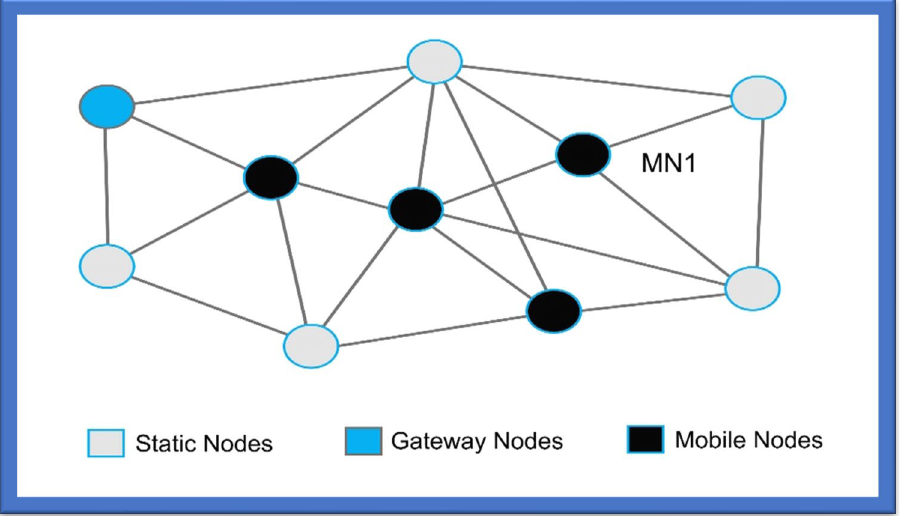
Figure 1. ZigBee Triangulation Mesh Network.